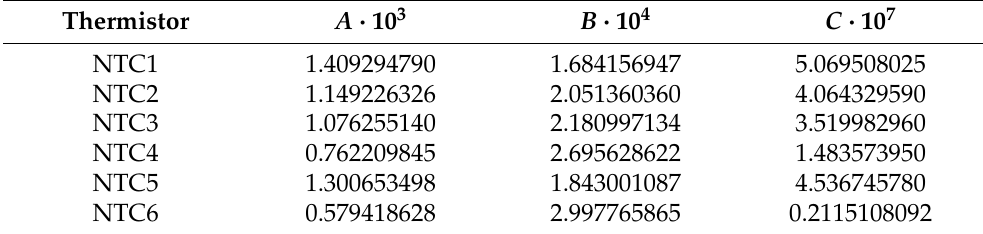
Table 4. Parameters of the Steinhart–Hart equation for the six NTC sensors. These parameters A , B and C are constants that are obtained for the equation that defines the resistance variation of the sensors. B were multiplied times 10 3 , B times 10 4 and C times 10 7